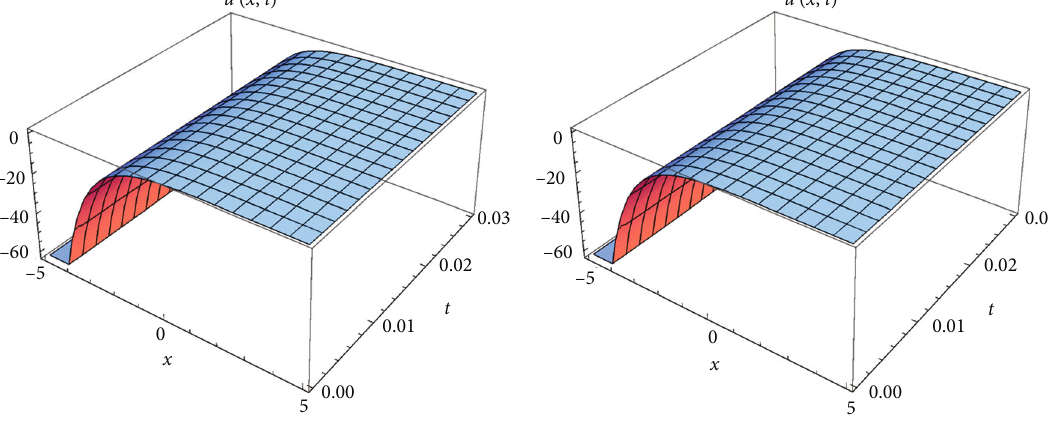
Figure 3: The surface solution of GD equation for Example